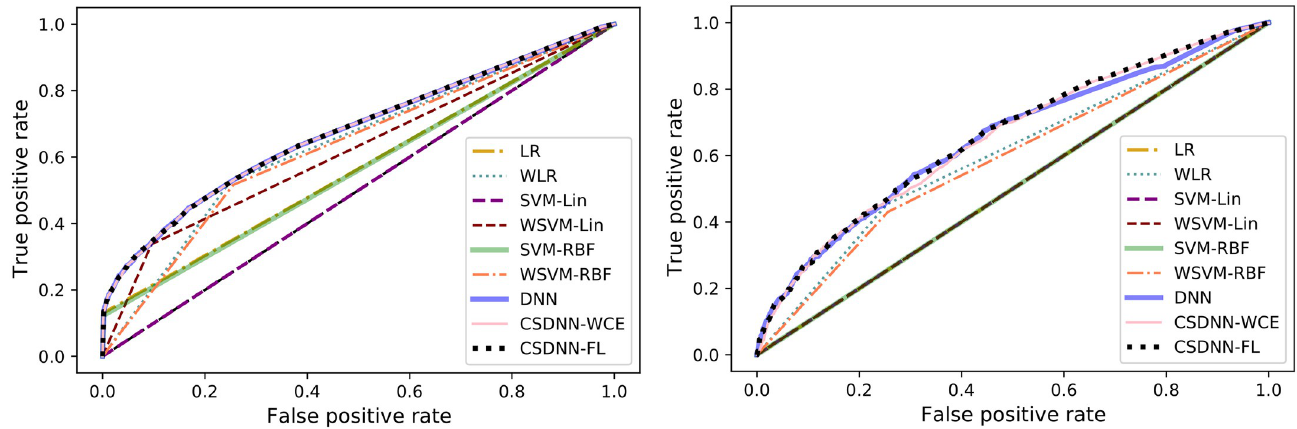
Fig 25. ROC curve for the Texas and Oklahoma dataset.